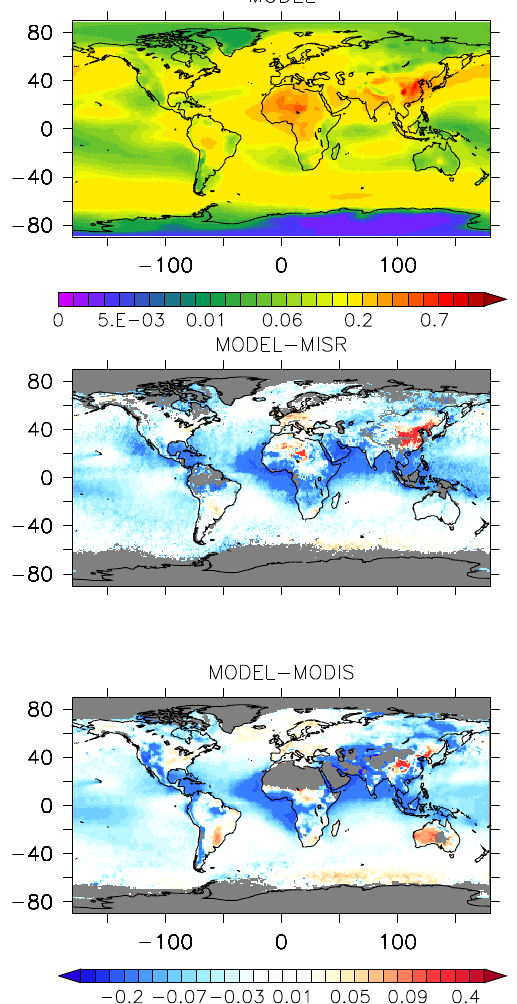
Fig. 1. Top: annual average AOD modelled by EMAC for the years 2005–2008. Bottom: annual average AOD difference between model results and MODIS and MISR observations (level 3 product) for the years 2005–2008. In grey the regions with less than 12 ob- servations during the period